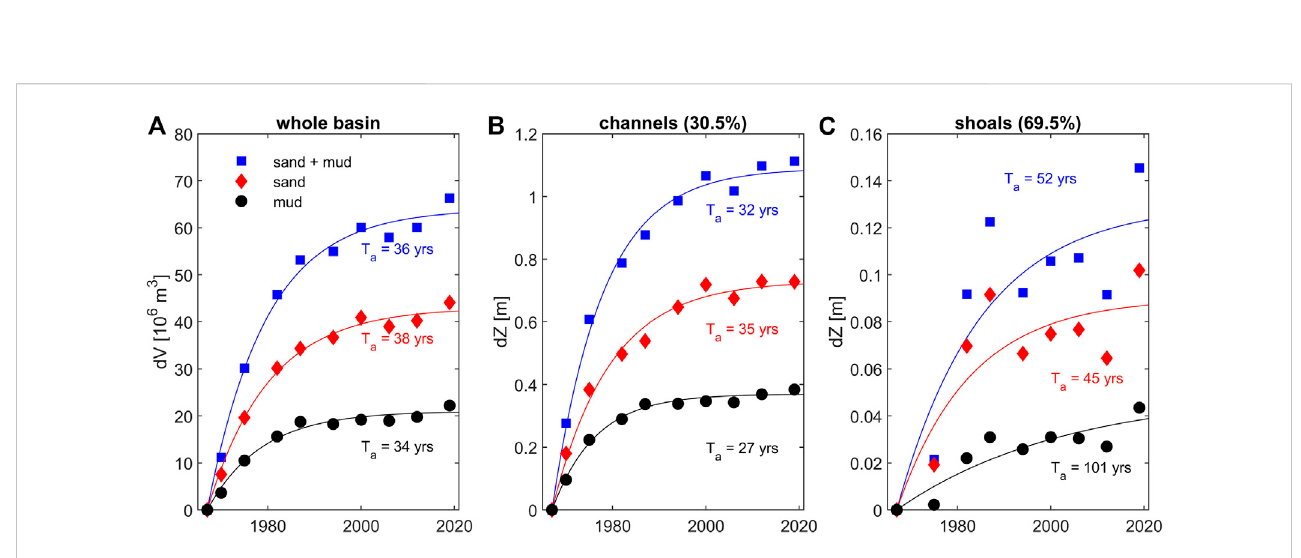
FIGURE 11 As Figure 9, but with volume changes corrected for SLR (using the curve from Figure